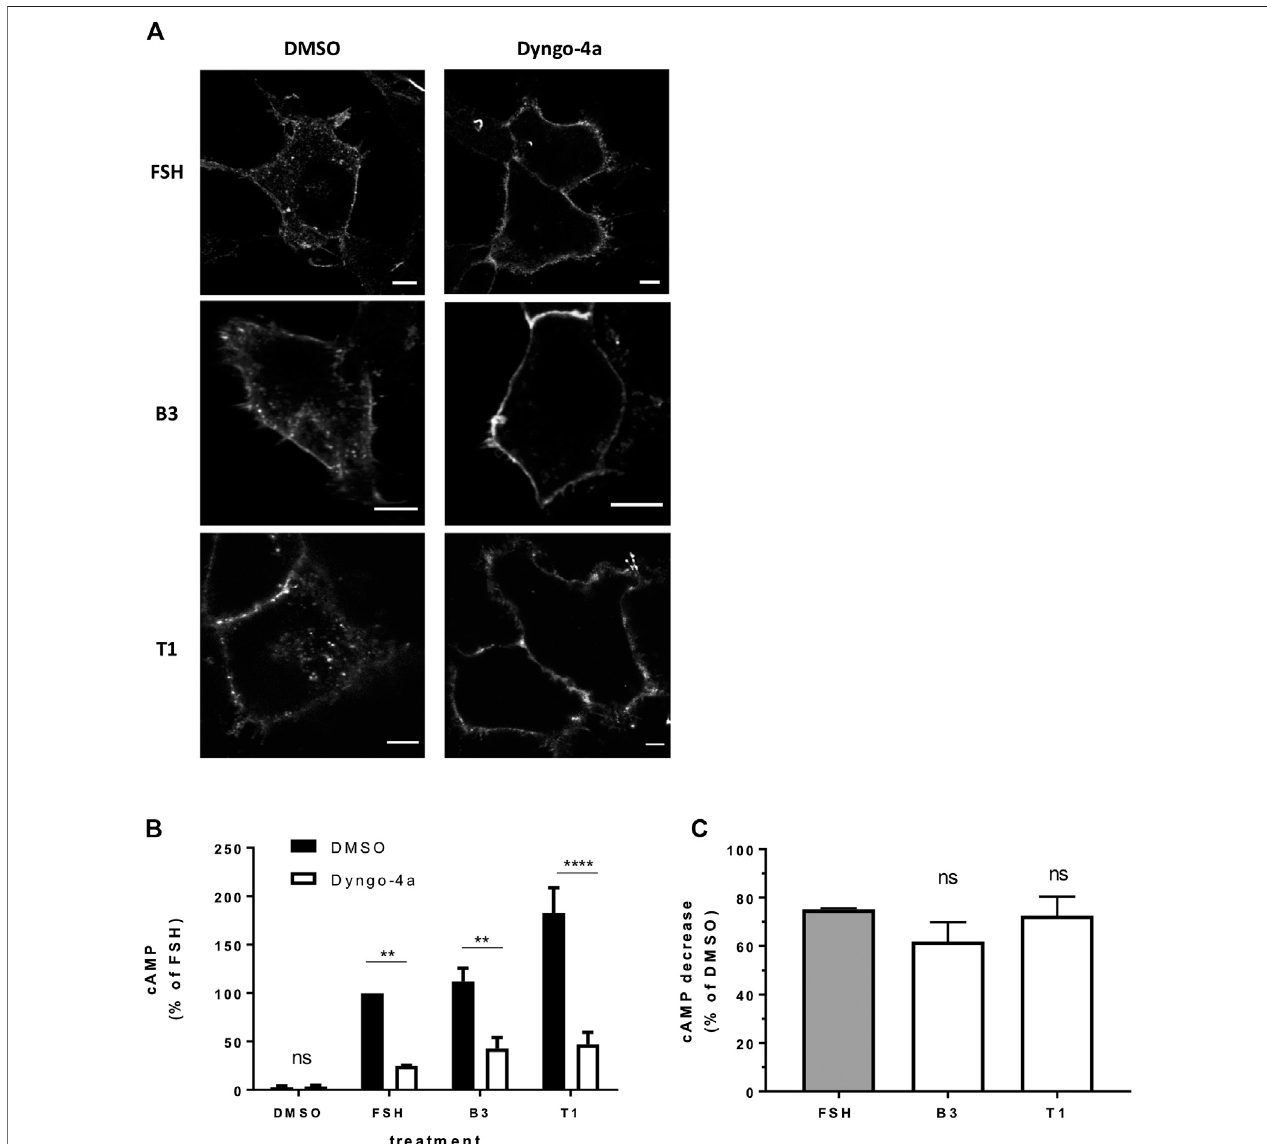
FIGURE 4 | FSHR requires receptor internalization to induce cAMP signaling in response to either FSH or LMW agonists. (A) Confocal images of FLAG- FSHR stably expressing HEK 293 cells pre-treated with either DMSO or Dyngo-4a (30 μ M, 30 min) and stimulated with FSH (10 nM), B3 (10 μ M) or T1 (10 μ M). Scale bar (cid:2) 5 μ m. (B) Intracellular levels of cAMP measured in cells via HTRF expressing FLAG-FSHR pre-treated with either DMSO or Dyngo-4a (30 μ M, 30 min) and stimulation either DMSO, FSH (10 nM, 5 min), B3 or T1 (10 μ M, 5 min). Data are expressed as cAMP levels normalized to FSH treatment (DMSO). Two-way ANOVA: ** p < 0.01, **** p < 0.0001. (C) Percentage decrease in cAMP levels following Dyngo-4a pre-treatment calculated from (B) . n (cid:2) 3 independent experiments.